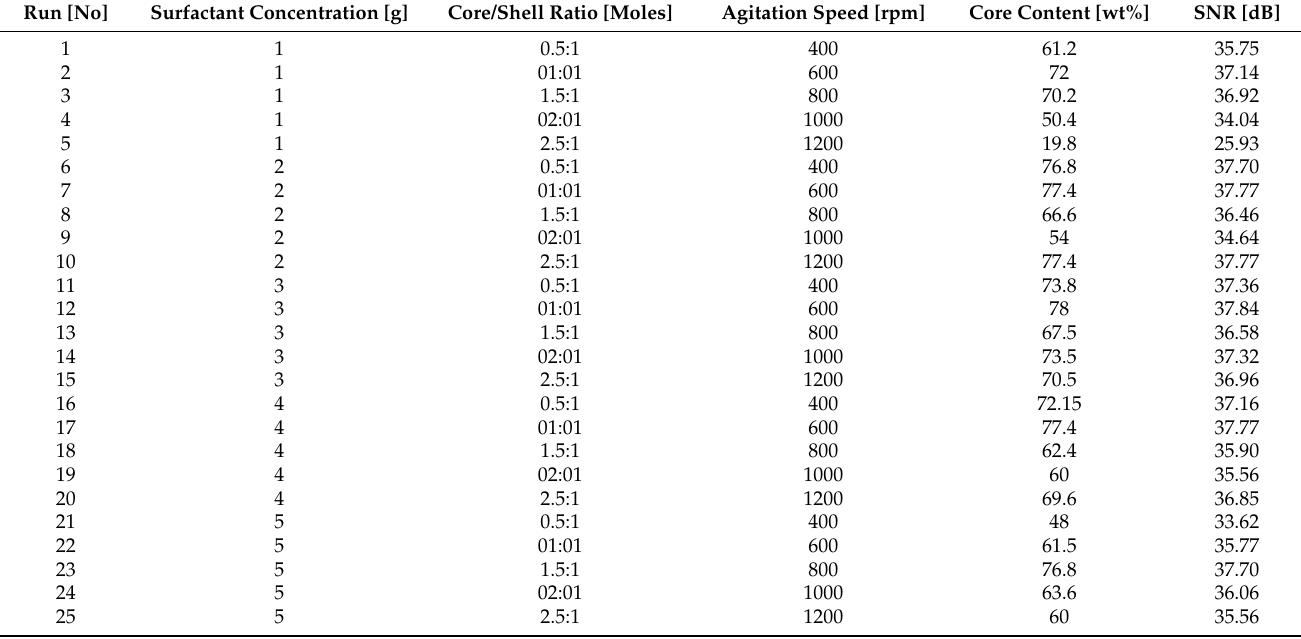
Table 1. Taguchi L 25 orthogonal array with signal to noise ratio